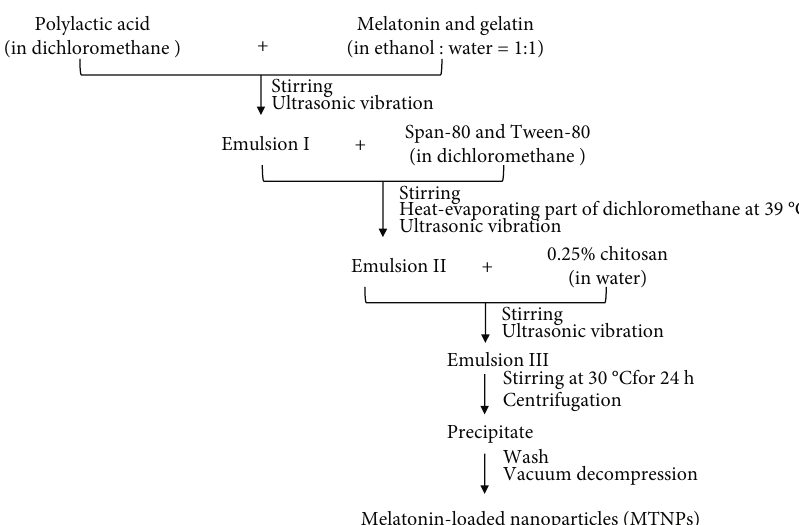
Figure 1: Schematic presentation of the preparation of melatonin-loaded nanoparticles